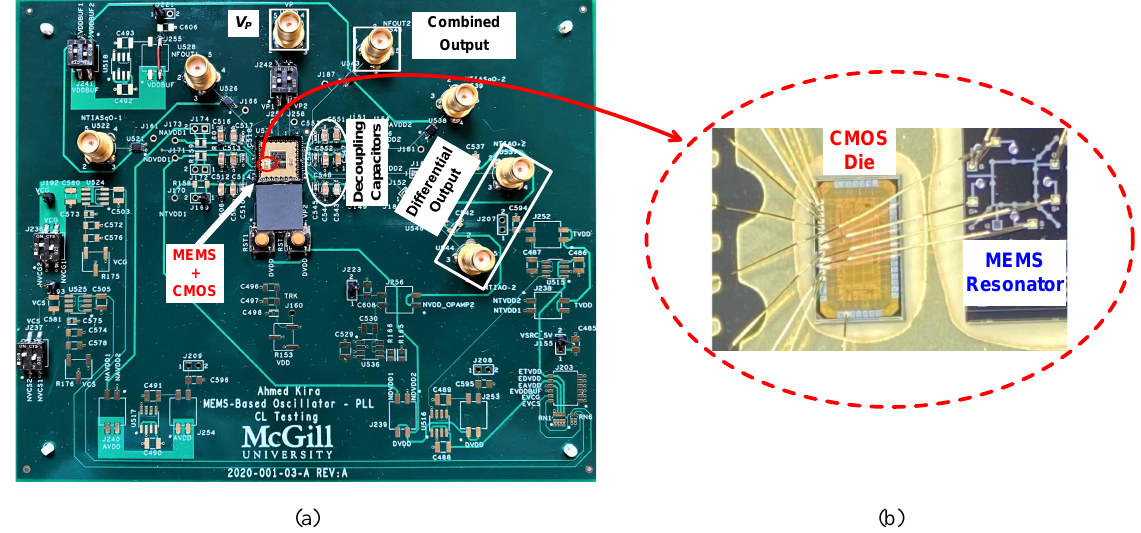
Figure 17. ( a ) Photograph of the testing board used to test the oscillator. ( b ) Picture of the wire-bonded dies, CMOS and MEMS, in the